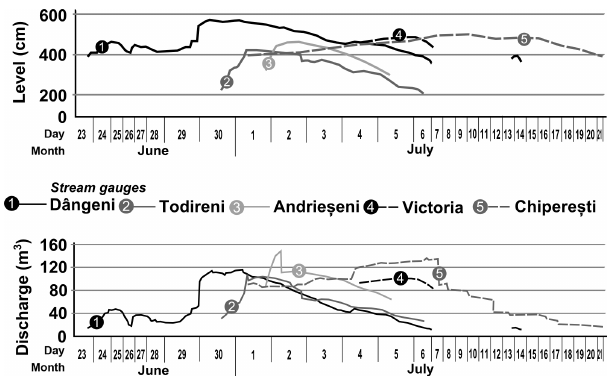
Figure 8. Water levels and discharge on the Jijia River at the gaug- ing stations of Dangeni, Todireni, Andrieseni, Victoria, and Chiper- esti during the summer of 2010.